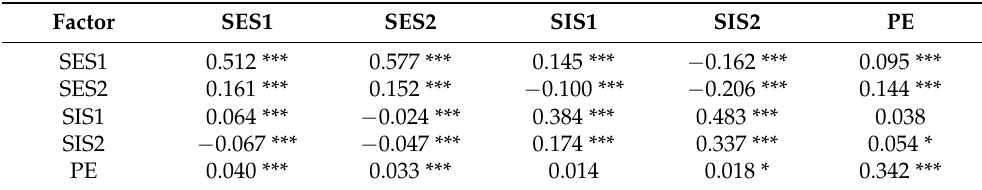
Table 4. Estimated covariance and correlation matrices for the latent factors.